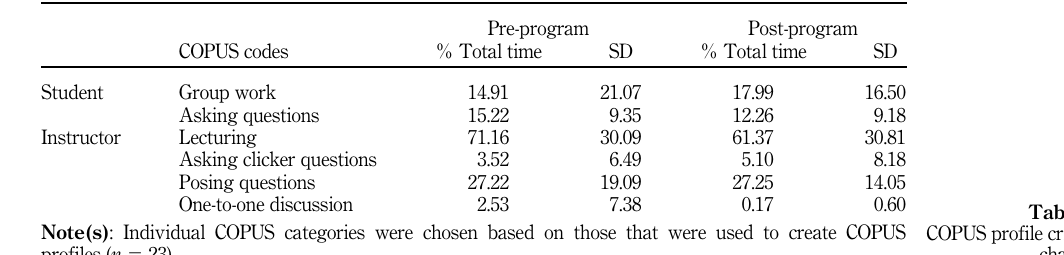
Figure 4. Observed pre-/post- program COPUS profile